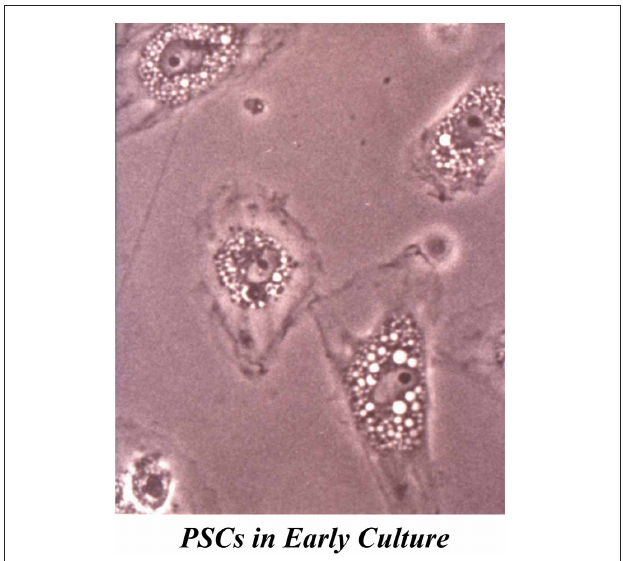
FIGURE 2 | PSCs in early culture. The cells exhibit a flattened polygonal shape with abundant lipid droplets (containing vitamin A) in the cytoplasm, surrounding the central nucleus. Reprinted with permission from BMJ Group.